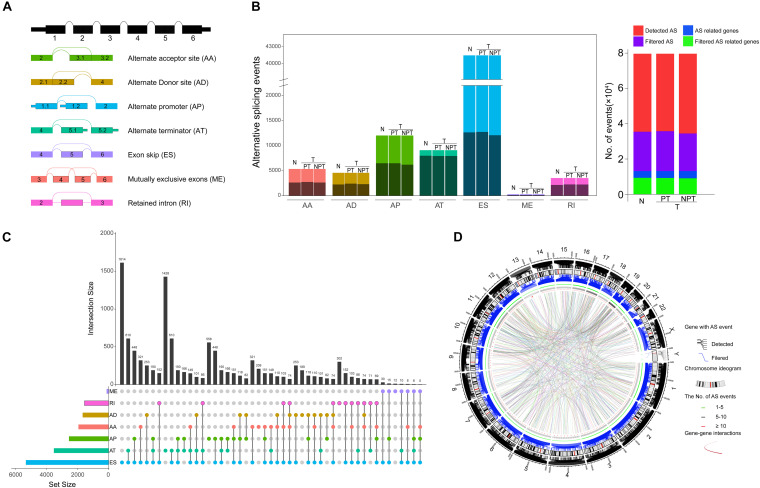
Landscape of alternative splicing (AS) events in hepatocellular carcinoma (HCC). (A) Diagrammatic sketch of the seven types of AS events in the present study: alternate acceptor site (AA), alternate terminator (AT), alternate promoter (AP), exon skipping (ES), mutually exclusive exons (ME), alternate donor site (AD), and retained intron (RI). (B) Number of AS events and the corresponding parent genes illustrated according to AS type (Left panel). The color bar represents AS events filtered by criteria. The black bar represents the corresponding genes involved in AS. Each AS type was divided into four groups based on the tissue source. N, normal tissue; T, tumor tissue; PT, paired tumor tissue; NPT, unpaired tumor tissue. Number of detected AS events, AS-related genes, filtered AS events, and the corresponding genes (right panel). (C) Intersection of parent genes between different AS types (n = 25,934) in HCC. One gene may incur up to four types of alternative splicing. (D) Circos plots depicting the distribution and the detailed alteration of AS events and their parent genes in chromosomes.